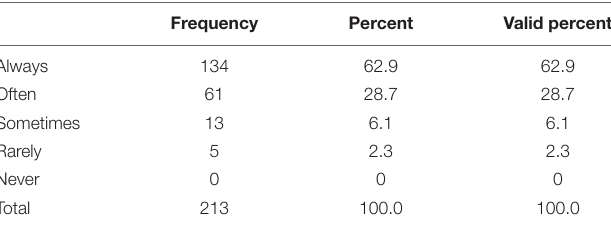
TABLE 8 | I use English whenever I communicate with